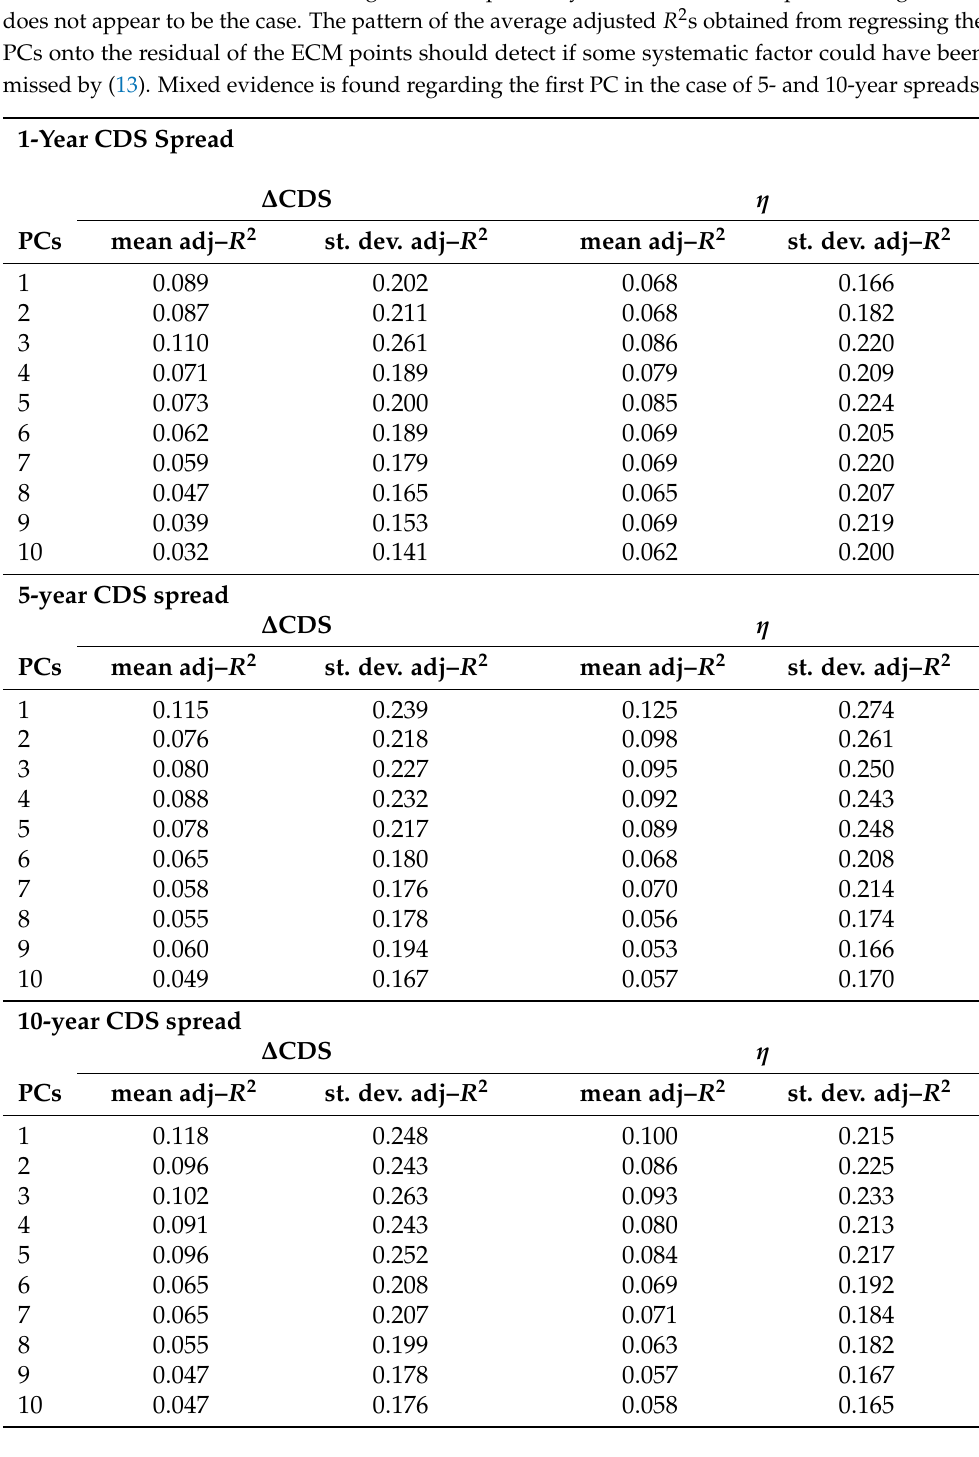
As last robustness check, the error correction parametrization in (13) is re-estimated for different values of the loss given default (60% and 80%). For the sake of brevity, the estimates are not reported but are available upon request. All the conclusions obtained in the previous section remain